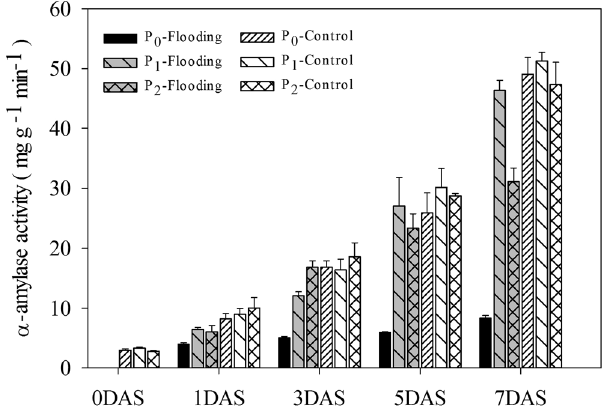
Figure 4. Variations in α -amylase activity of pelleted rice seeds and seedlings in two pelleting treatments under waterlogging (1.5 cm water layer) and normal (without water layer) conditions at 0, 1, 3, 5, and 7 DAS in Experiment 3. P 0 : non-pelleted naked seeds; P1: Seed pelleting time of three with a CaO 2 content of 20% in formula 1; P 2 : Seed pelleting time of three with a CaO 2 content of 20% in formula 2. Seeds at 0 DAS were tested under a dry weight basis, while seedlings at 1, 3, 5 and 7 DAS were tested under a fresh weight basis. Error bars above the mean indicate standard error (n = 4).